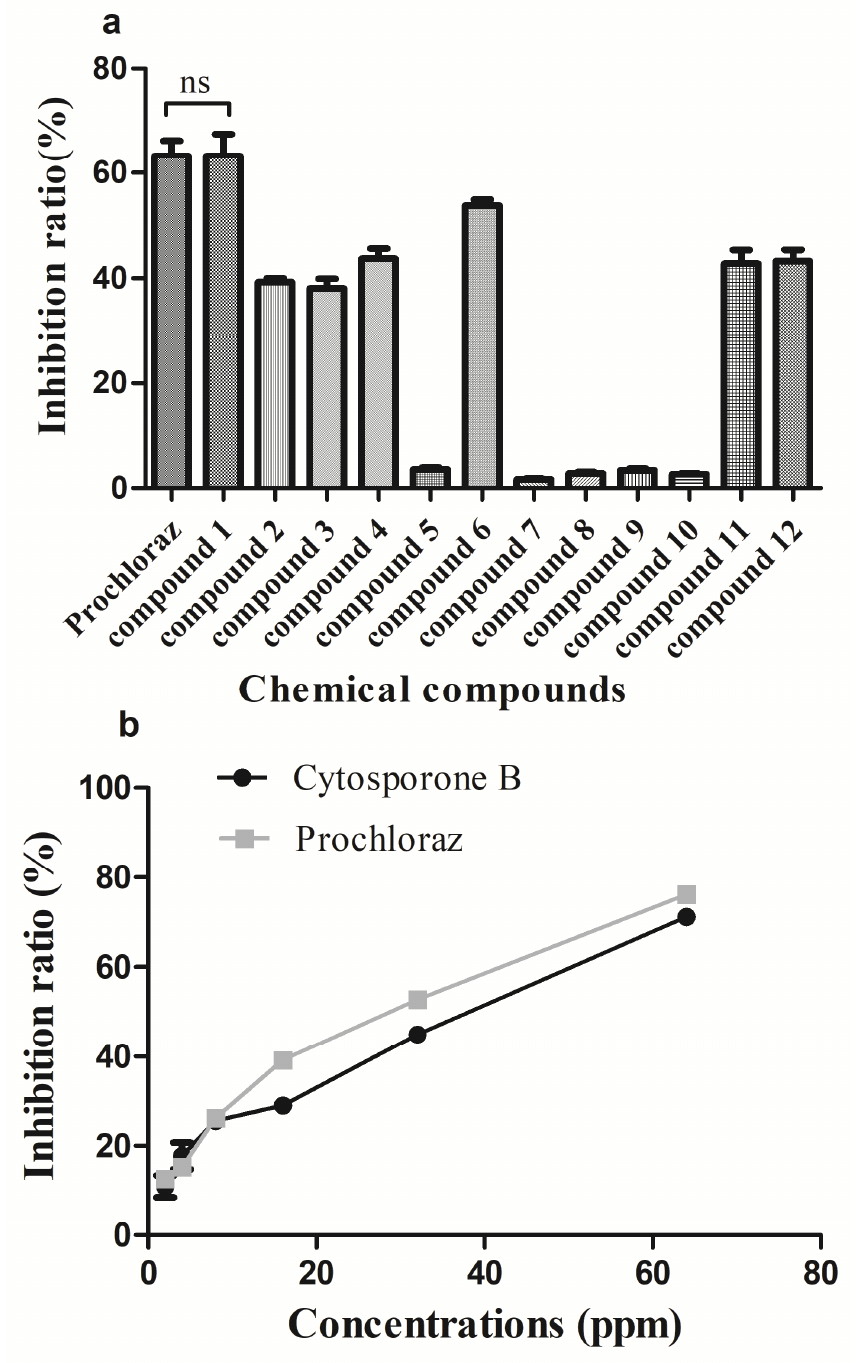
Figure 2. Effect of isolated chemicals ( a ) and cytosporone B ( b ) on mycelial growth of Geotrichum citri-aurantii on potato dextrose agar plates. Vertical bars represent the standard error of the means; ns means no significant difference.